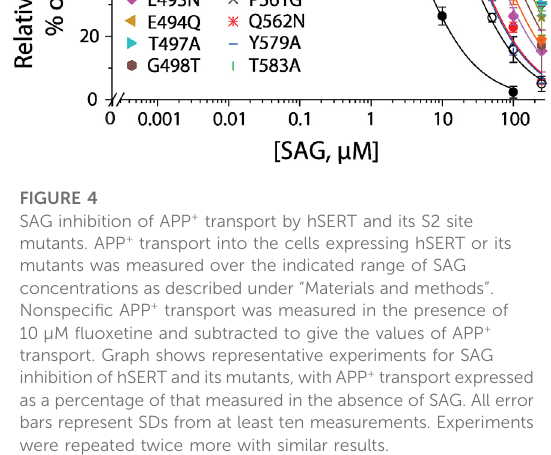
mutants of hNET, F317A, D473N, and T474Q, showed little change in SAG inhibition potency compared to WT-hNET. On the other hand, SAG IC50 values were increased by less than 10 folds in two mutants, K541G and L563A, but more than 25 folds in other two